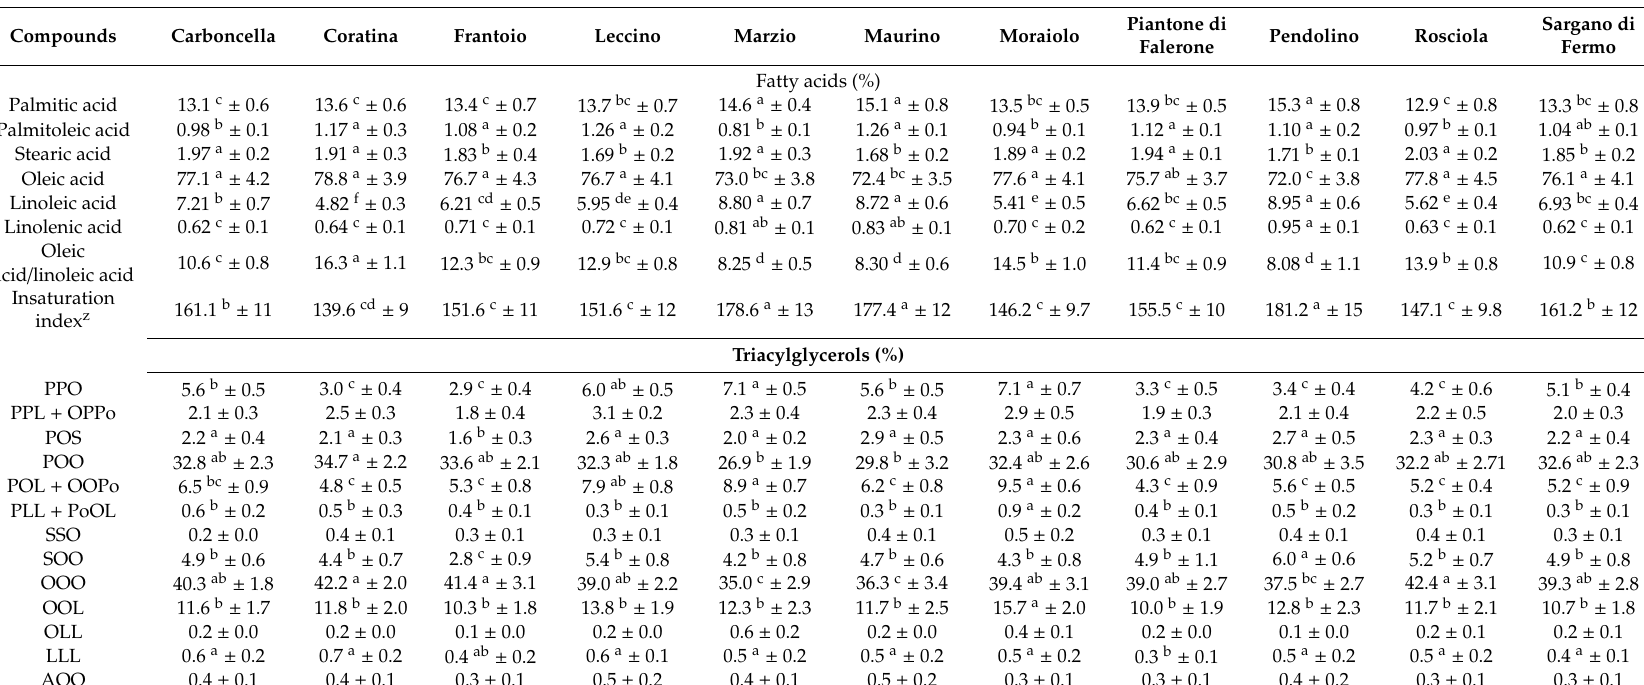
Table 3. Fatty acid composition, oleic acid:linoleic acid ratio, insaturation index and triacylglycerols composition of the eleven monovarietal extra virgin olive oils